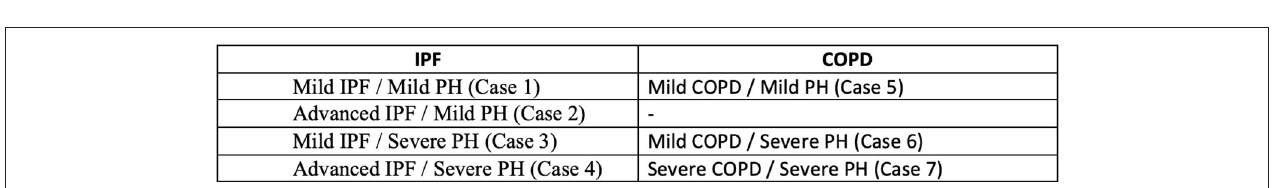
FIGURE 2 | PH-CLD phenotypes for each of the seven hypothetical cases. Severe PH was defined as a mPAP > 35 mmHg, severe IPF was defined as FVC < 70%, and severe COPD was defined as FEV1 < 60%. These values were based on the 6th WSPH Group 3 task force recommendations ( 1).